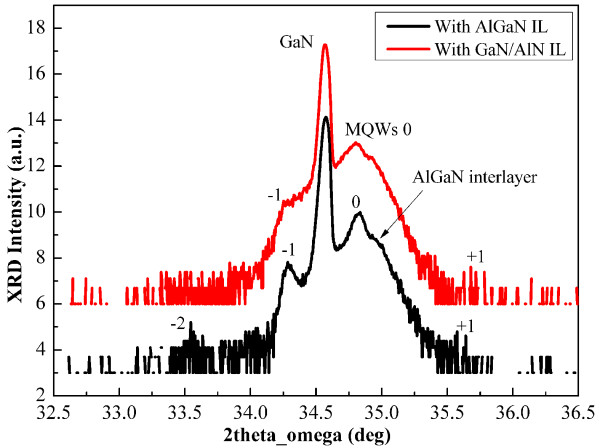
(0002) ω-2θ scan of samples A and B. IL stands for interlayer.